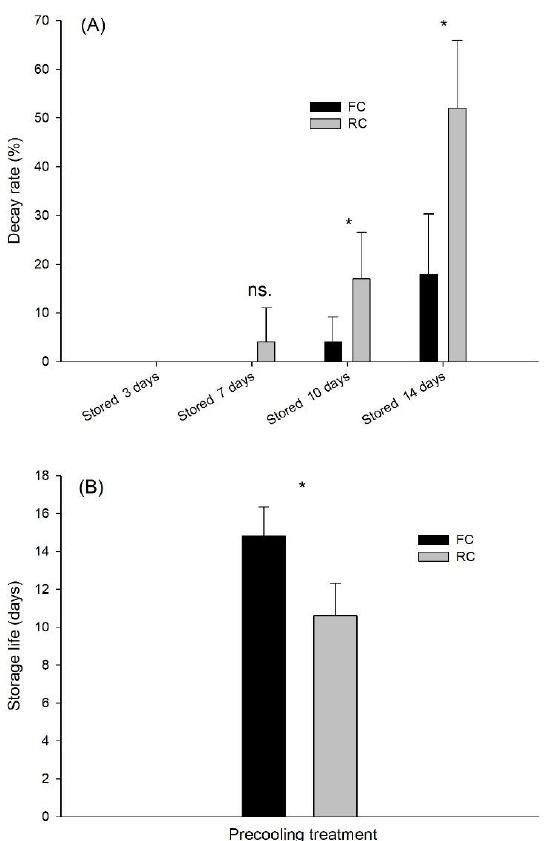
Figure 5. Effects of FC and RC on the ( a ) decay rate and ( b ) shelf life during the storage of winged bean pods. * Significant differences between the two treatments according to the least significant difference test ( p < 0.05). ns. — non-significant difference between the two groups. Data are expressed as mean ± SD of ten replicates ( n = 10).